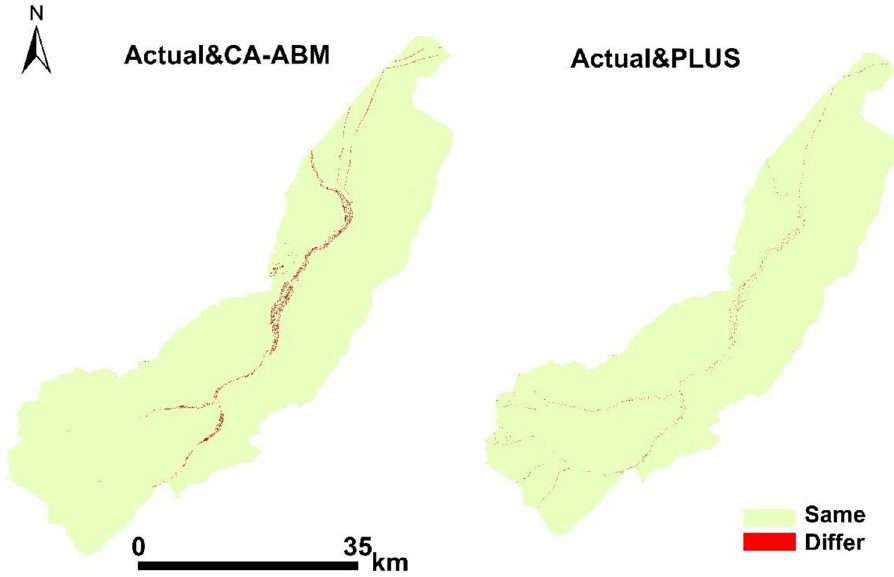
Fig 12. Simulation result and actual map of QPT in 2018. (Software: ArcMap 10.2.0, http://www.esri.com).